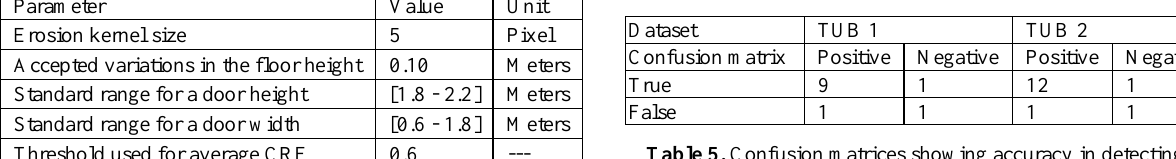
Table 5. Confusion matrices showing accuracy in